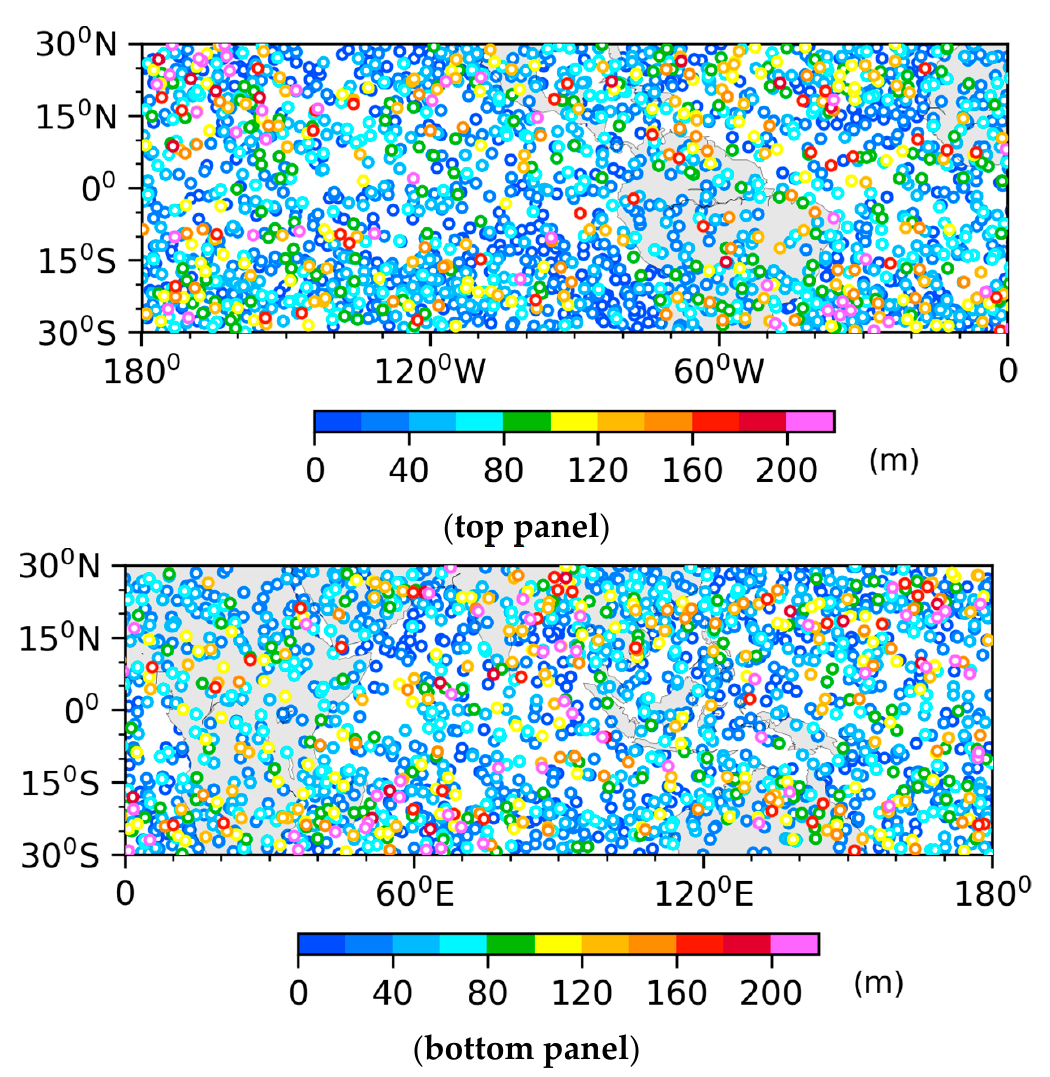
Figure 2. Spatial distributions of the COSMIC occultations within [30° S, 30° N] during 1–10 January 2009 in the western ( top panel ) and eastern ( bottom panel ) hemispheres. The GNSS and LEO satellite positions are to the left and right directions on the x -axis, respectively. The values of maximum a r 0 ∓ 480km are indicated in colors.